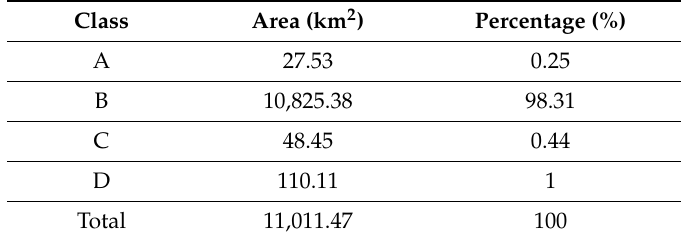
Table 14. Hydrological group analysis for Al-Shamal train pathway in Al-Qurayyat city in